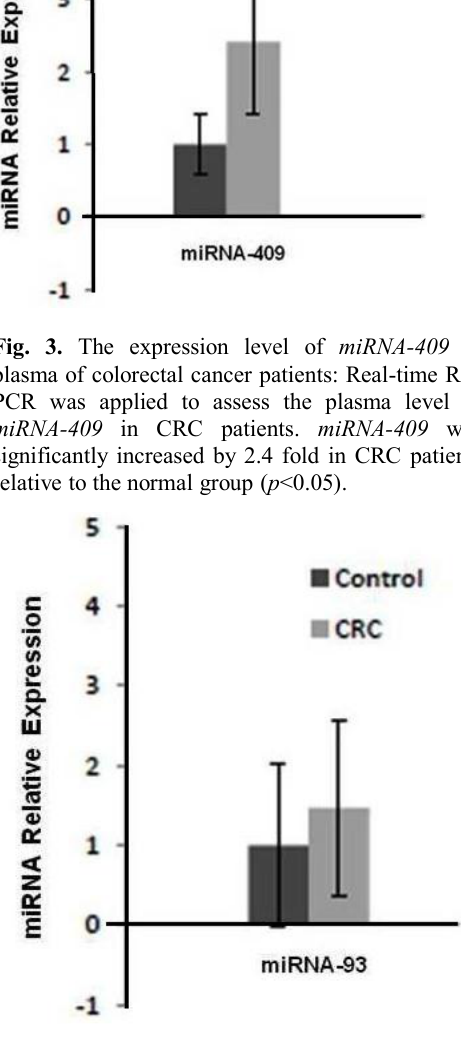
Fig. 4. The expression level of miRNA-93 in plasma of colorectal cancer patients: Real-time RT-PCR analysis showed that the plasma level of miRNA-93 was elevated in CRC patients relative to the normal group, while the difference was not significant (p